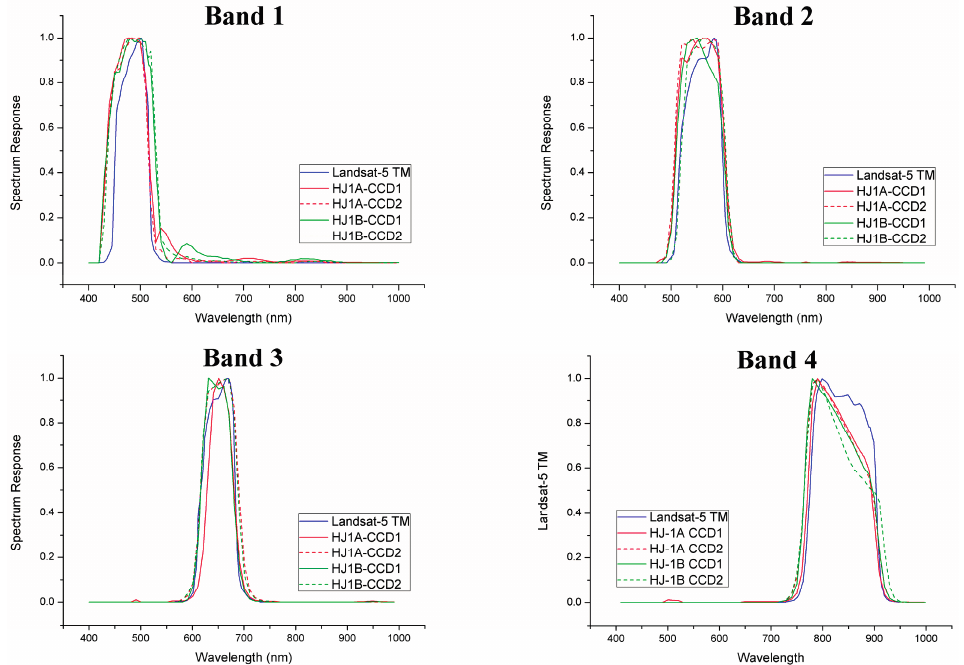
Figure 2. The spectrum response function of multi-spectral bands of the Landsat-5 TM and HJ1A/B